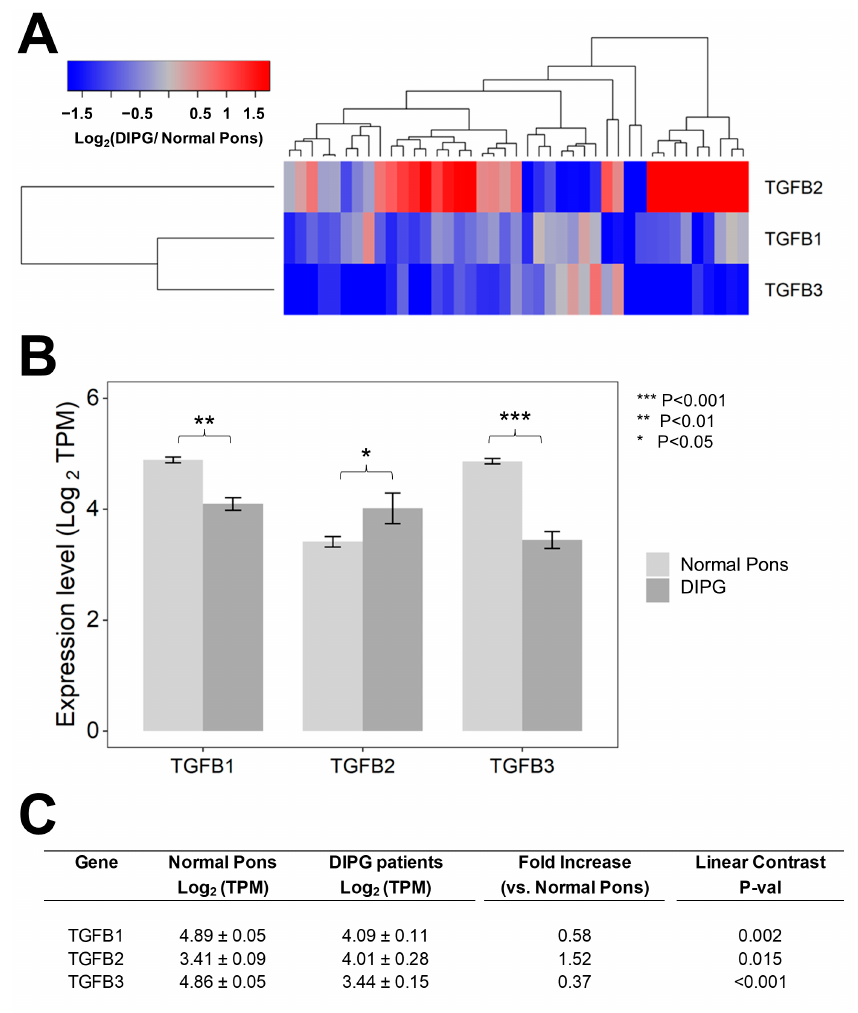
Figure 1. Selective upregulation of TGFB2 mRNA expression in DIPG tumor samples. Archived TGFB1/2/3 mRNA expression levels (in log 2 -transformed TPM) for primary tumor samples from 41 DIPG patients, including 11 DIPG patients with unknown H3K27M mutational status, 4 H3K27M-mutant DIPG patients, and 26 H3K27M-mutant DMG patients, whose brain tumors were localized to pons/brainstem, obtained from cBioPortal were compared to TGFB1/2/3 mRNA expression levels (log 2 TPM) in normal pons samples from 29 pons regions (downloaded from https://www.proteinatlas.org/about/download, accessed on 17 December 2022). The TGFB2 expression levels for these 29 normal pons regions were determined by averaging the TPM values for 2–8 independent samples/region from 21 subjects. Expression of log 2 -transformed TPM values for TGFB1/2/3 mRNA levels in the tumor samples from DIPG patients were mean-centered to the mRNA expression levels in normal pons samples and depicted in the heatmap ( A ) representing overexpression (red color) or underexpression (blue color). ( B ) The bar charts illustrate reduced expression levels for TGFB1 and TGFB3 mRNA but amplified expression levels for TGFB2 mRNA, in tumor specimens from DIPG patients (dark grey bars) when compared to normal pons samples (light grey bars). ( C ) Statistical significance of differences in TGFB1/2/3 mRNA expression levels (in log 2 -transformed TPM values) was assessed using two-way ANOVA with linear contrasts using FDR-adjusted p -values. We documented a statistically significant 1.52-fold increase in TGFB2 mRNA levels ( p = 0.015) along with statistically significant decreases in TGFB1 mRNA (1.72-fold decrease; p = 0.002) and TGFB3 (2.7-fold decrease; p < 0.001) mRNA levels.